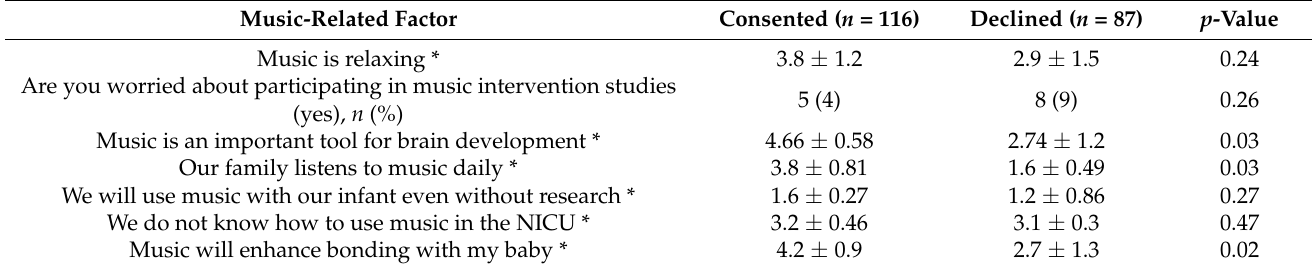
Table 2. Music-related factors of those who consented or declined music therapy intervention studies. Music-Related